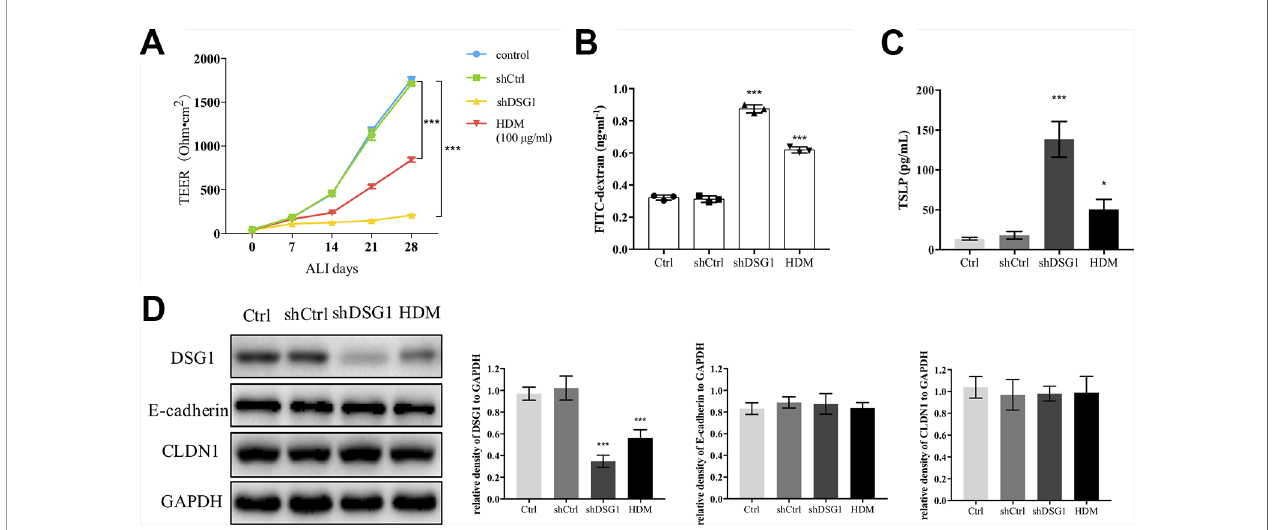
FIGURE 6 | HDM-induced DSG1 de fi ciency resulted in epithelial barrier compromise. 16HBE cells were transfected by shDSG1 or treated with HDM at 100 m g/ml for 24 h. After forming a con fl uent monolayer, cells were subsequently cultured at ALI. Similar to shDSG1, HDM signi fi cantly perturbed barrier integrity as demonstrated by (A) reduced TEER and (B) escalated FITC-dextran in fl ux; Furthermore, (C) TSLP in culture medium detected by ELISA and (D) protein expression of DSG1 determined by Western blot suggested that HDM might in fl uence the epithelial barrier by down-regulating DSG1 and increasing the expression of TSLP. (All data represent mean ± SD from three independent experiments performed in triplicate, n = 3, * P < 0.05, *** P < 0.001 versus control). HDM, house dust mite; DSG1, desmoglein 1; TEER, transepithelial electrical resistance; TSLP, thymic stromal